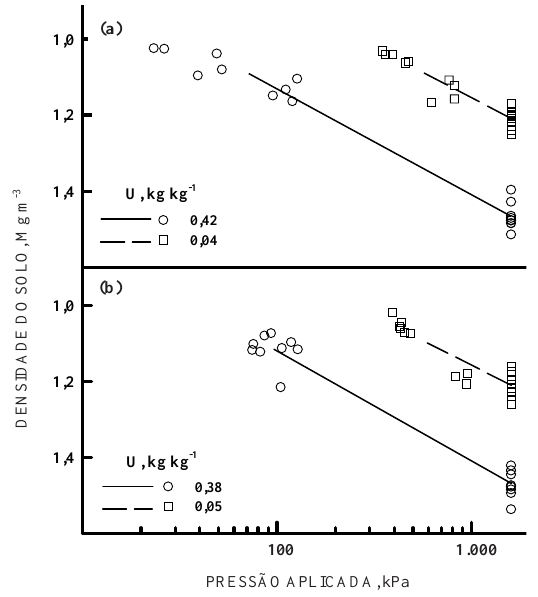
Figura 6. Retas de compressão virgem ajustadas para o Latossolo Vermelho-Amarelo, Latossolo Roxo e Latossolo Vermelho-Escurosob cultivo anual, nas profundidades de 0-0,03 (a) e 0,27- 0,30 m (b), com a maior e a menor umidade gravimétrica (U) utilizadas (n = 18).